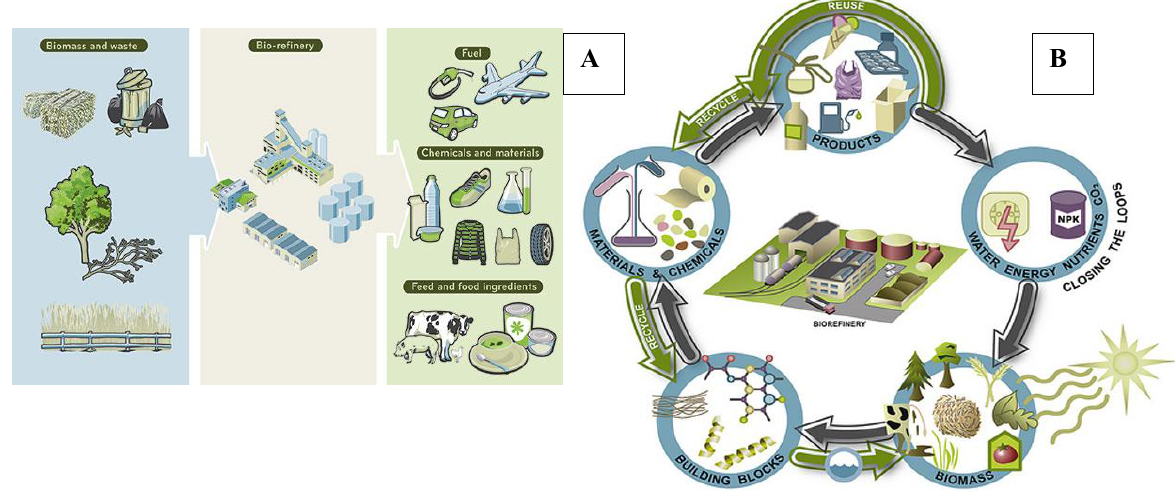
Fig. 1: The biobased industry: a) the activities’ frame from raw material to industrial products; b) the modern concept of global order accor- ding to bioeconomy vision. Source: http://biconsortium.eu